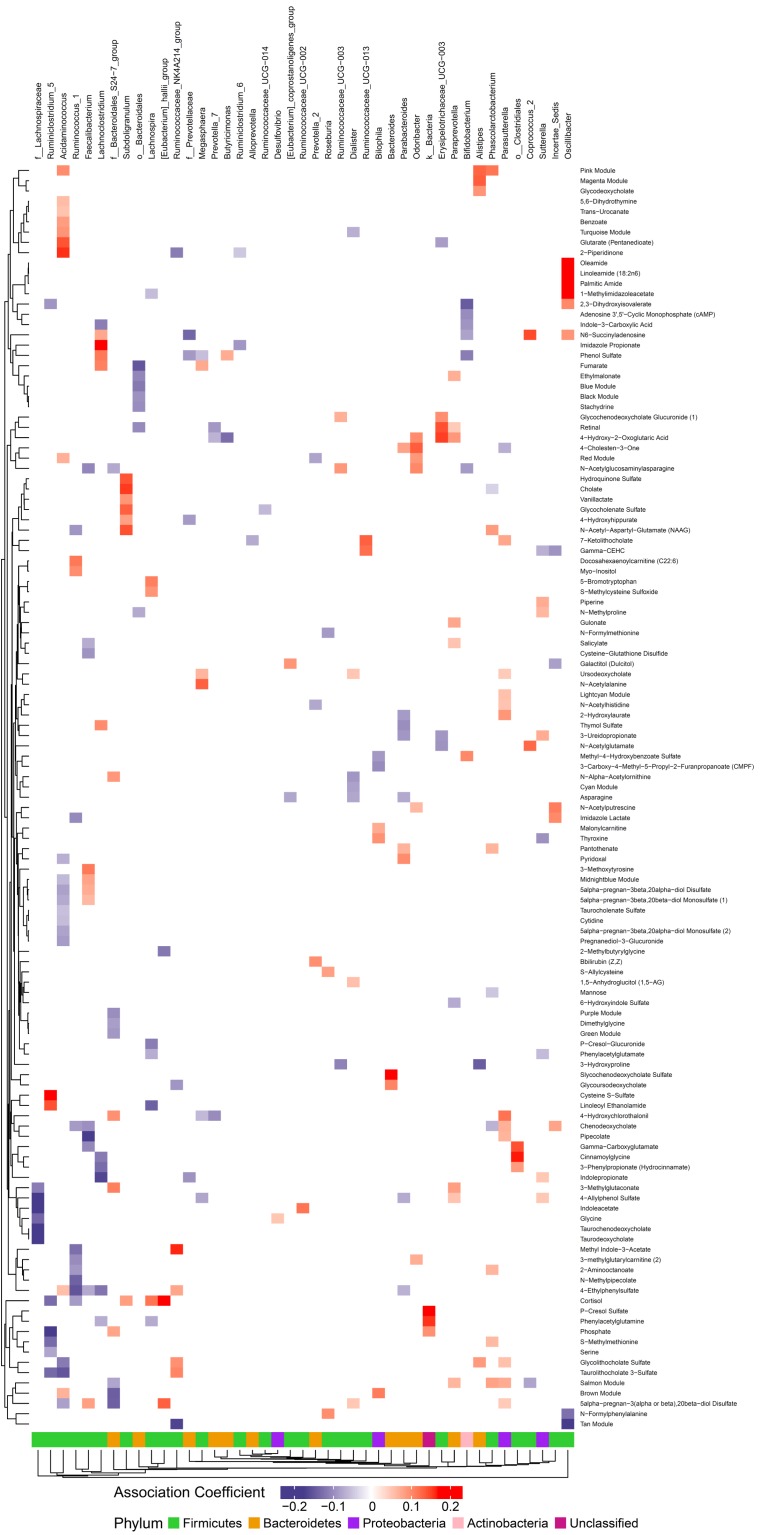
Associations between gut microbiome and metabolites in plasma. Color intensity reflects the magnitude of the association coefficients between metabolites and taxa.